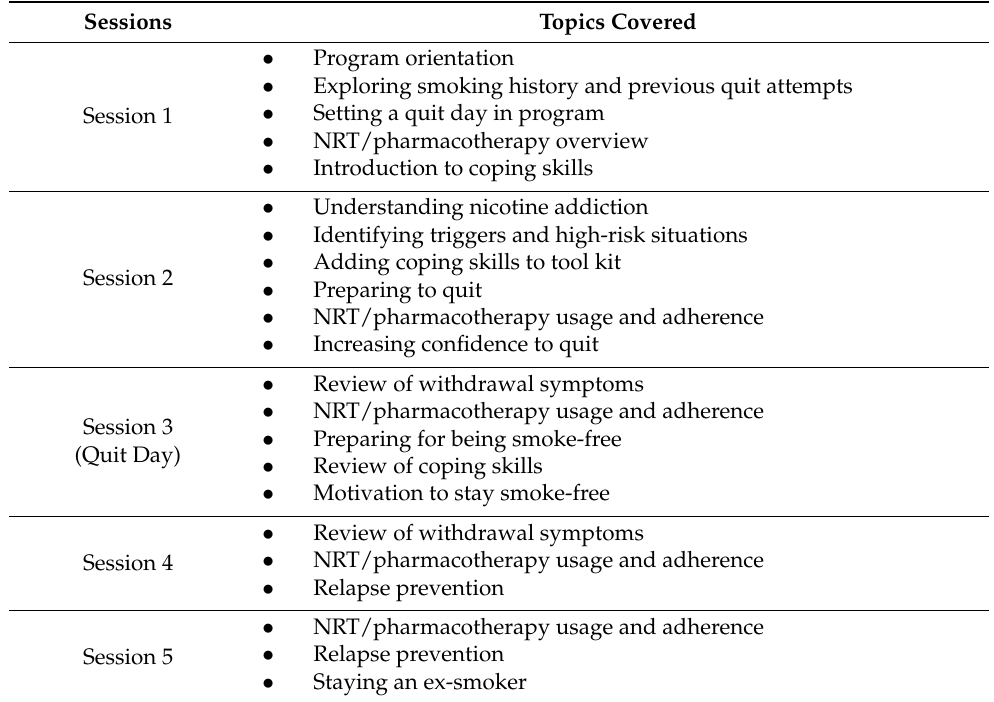
Table 1. Outline of quitline counseling sessions.